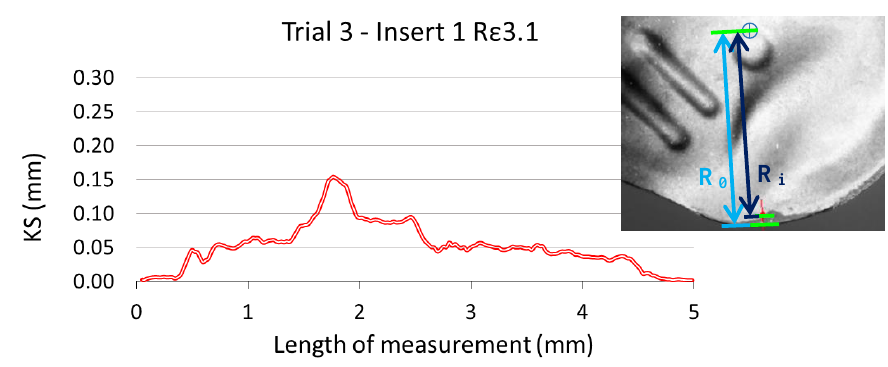
Figure 17. Measured KS of insert 1 during trial 3 (removed volume 13.9·10 4 mm 3 ) and two overlapping images of rake face: reference insert (background) and worn insert (first plane).